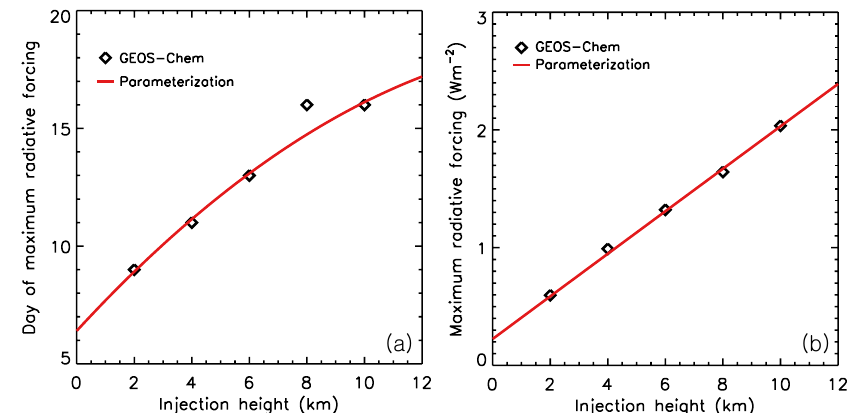
Fig. 10. (a) Scatter plot of the volcanic SO 2 injection height (km) and the days (after the eruption) when the peak of daily and global averages of volcanic sulfate shortwave forcing occurs. The data are based upon results in Fig. 9. (b) same as (a) but shows the peak value of the daily and global average of volcanic sulfate shortwave forcing. The red lines in (a) and (b) respectively show the results based upon the parameterizations as described in Sect. 4.3.